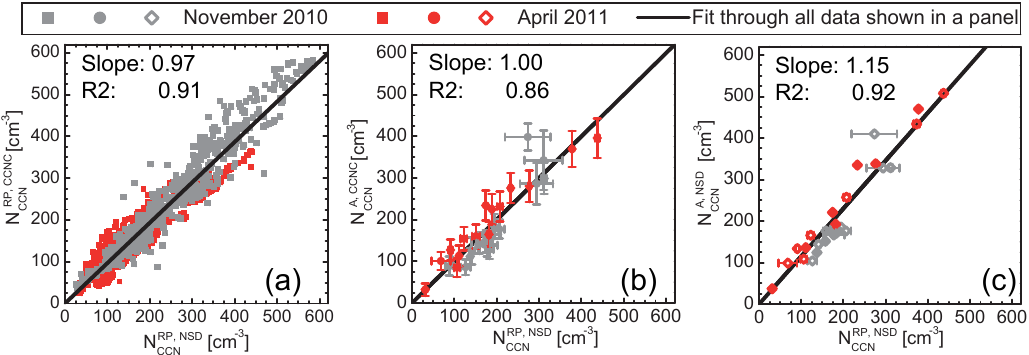
Figure 5. Scatterplot comparing the N CCN data sets shown in Fig. 4. N RP,NSD left, middle and right panel, respectively. Slope and R 2 for these fits is given in the panels. (For clarity, the error bars were omitted in the left panel, where, on average, a standard deviation of 20% was found for N RP,CCNC